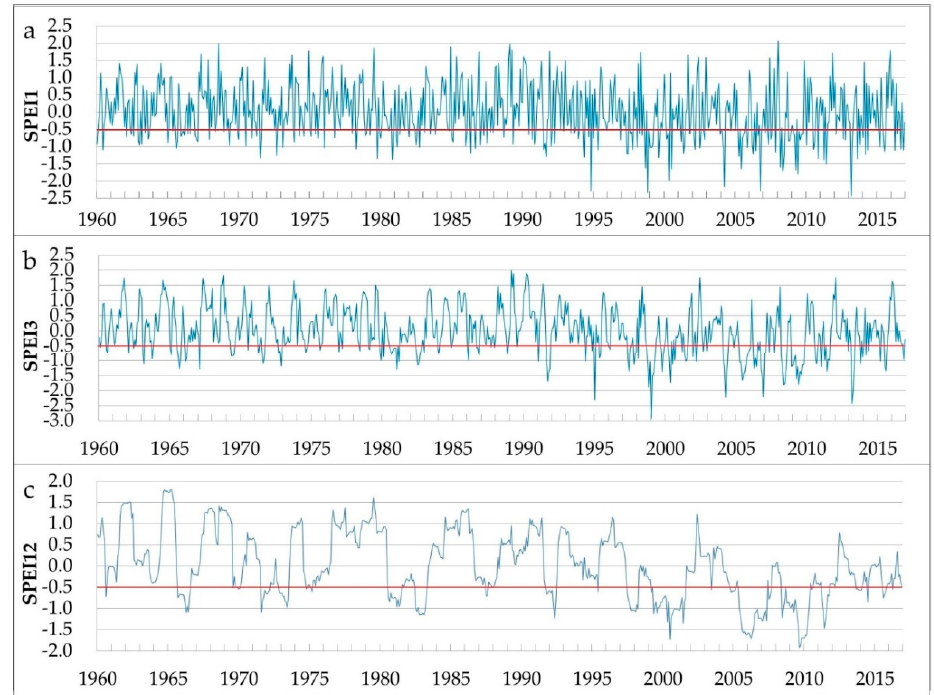
Figure 3. The standardized precipitation evapotranspiration index (SPEI) values at different timescales in Ningxia from 1960 to 2016. ( a ) SPEI1 in Ningxia from 1960 to 2016; ( b ) SPEI3 in Ningxia from 1960 to 2016; and ( c ) SPEI12 in Ningxia from 1960 to 2016.